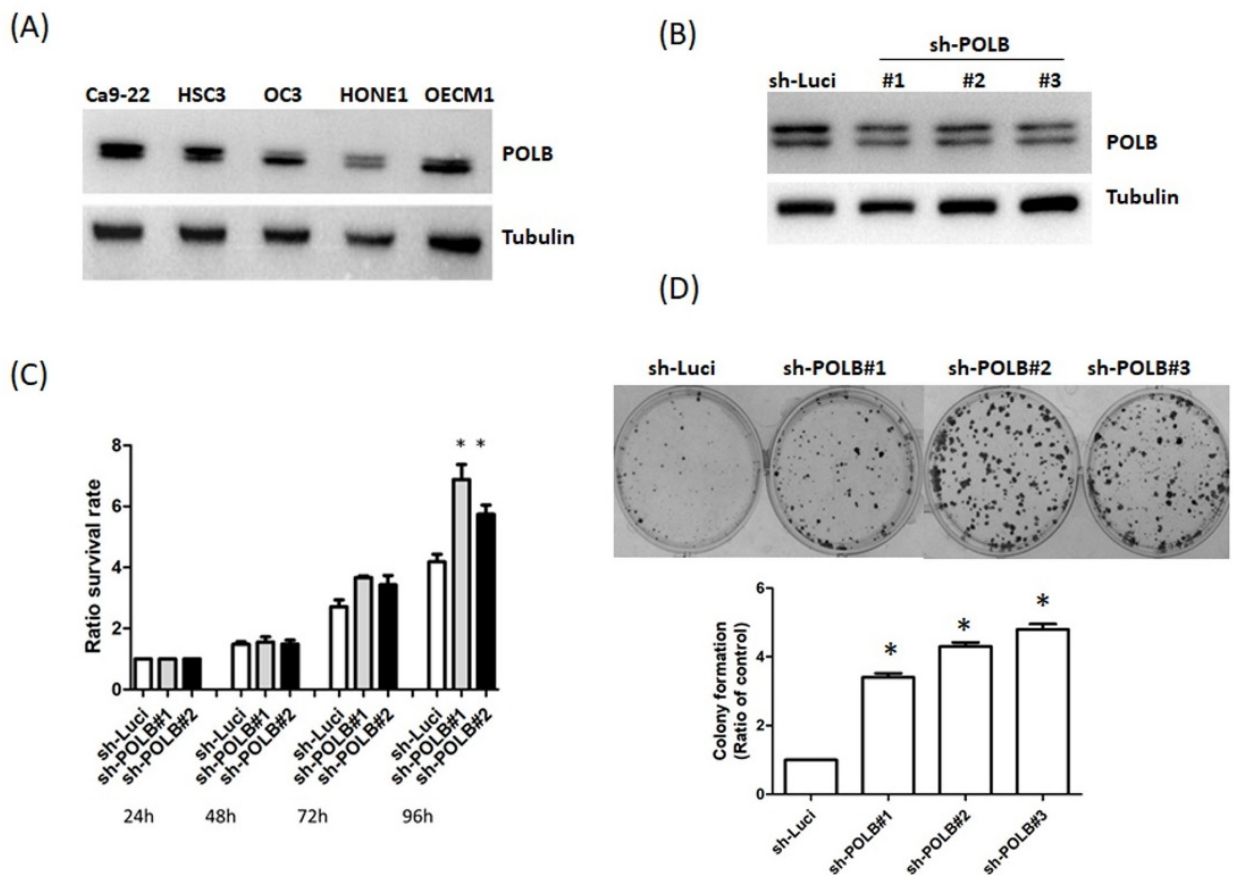
Figure 2. POLB knockdown triggers cell proliferation of OSCC cells. ( A ) Expression of POLB in five OSCC cell lines (Ca9-22, HSC3, OC3, HONE1 and OECM1). Cell lysates were immunoblotted by anti-POLB. Tubulin was used as a loading control. Experiments were performed independently at least three times. ( B ) The level of POLB protein was determined using Western blot analysis in stably POLB-depleted Ca9-22 cells. ( C ) MTT assays were performed for 24, 48, 72 and 96 h in parental and POLB-depleted cells. Values represent the mean ± SD from at least three independent experiments. Statistically significant data are indicated by * for significance at p < 0.05. ( D ) Clonogenic assay were performed in 5 × 10 2 parental Ca9-22 and POLB silencing (shPOLB) Ca9-22 cells. Quantitative analyses of clonogenic assay are shown in the right panel.